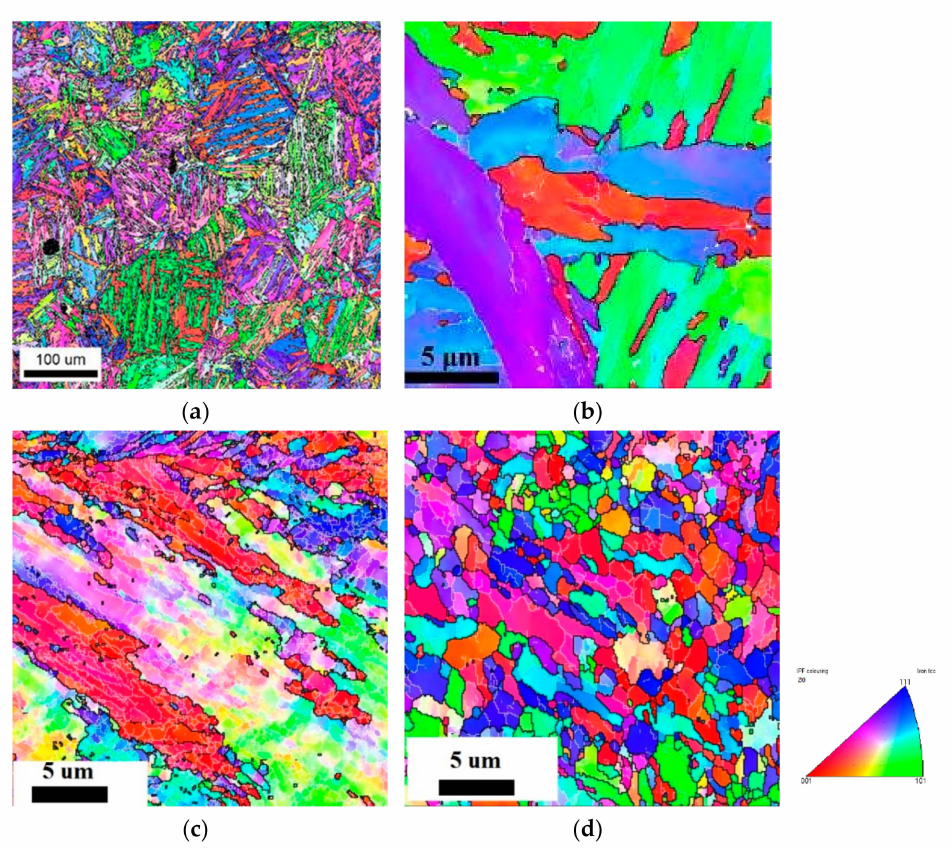
Figure 4. EBSD maps after ( a , b ) tempering; ( c ) CR; and ( d ) CR + requenching. Table 2. Parameters of the microstructure from the EBSD